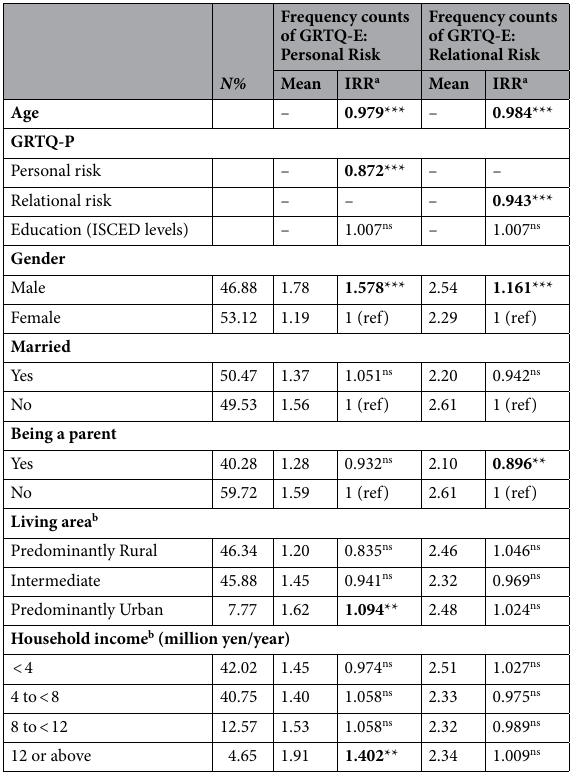
Table 3. Crude Association Models: Potential variables associated with the GRTQ-E Personal Risk and Relational Risk scores among all participants (n = 2984). IRR Incidence-Rate Ratio. a Controlled by age and gender. b Weighted effect coded because of the highly unbalanced group size. ns Not significant. ** p < 0.01, *** p < 0.001, Variables with p < 0.01 are in